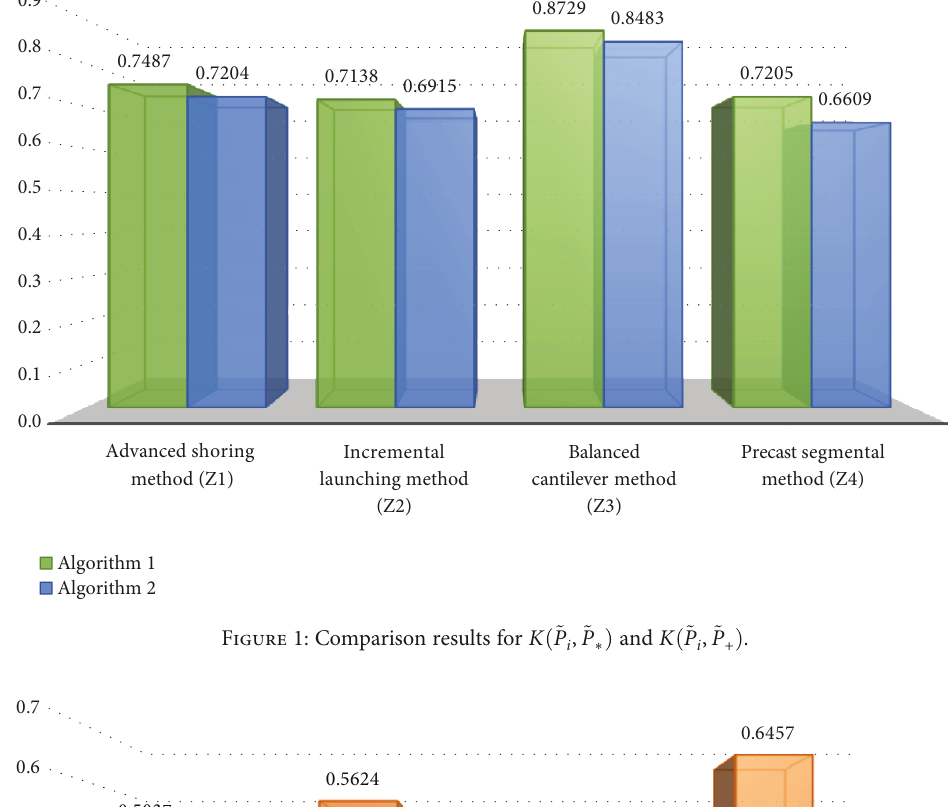
Figure 1: Comparison results for K P